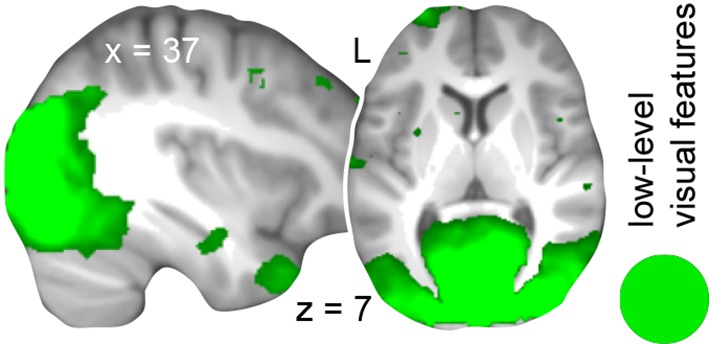
Multi-voxel representations of low-level visual features on day 1.Additional searchlight MVPA revealed distributed representations of low-level visual features, but not rule-based associations, during schema retrieval on day 1 (Materials and methods, Complementary analysis: AG involvement in schema retrieval on day 1). For display purposes, the map was resliced to a voxel dimension of 0.5 mm isotropic and is shown at P < 0.001, uncorrected. Significant clusters are noted in Table 6. L – left.